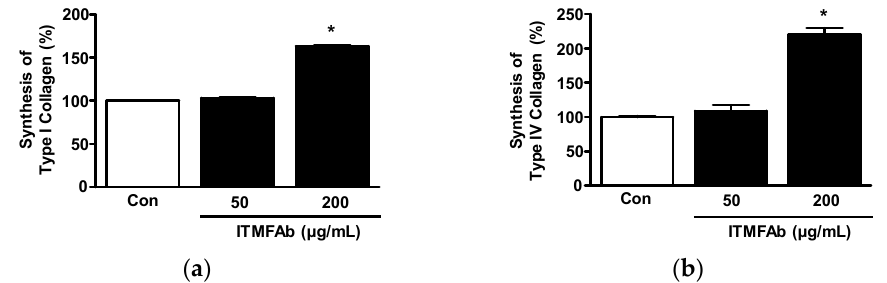
Figure 5. Effects of Impatiens textori Miq. flower absolute on the syntheses of type I and IV collagens. HaCaT cells were cultured with or without Impatiens textori Miq. flower absolute (ITMFAb; 50 and 200 µ g/mL) for 48 h and sandwich ELISA was performed in conditioned media using anti-type I ( n = 3; ( a )) or anti-type IV collagen antibody ( n = 3; ( b )). Collagen levels in conditioned media in non-treated controls (Con) were considered 100%. Data are expressed as means ± SEMs. * p < 0.05 vs. non-treated